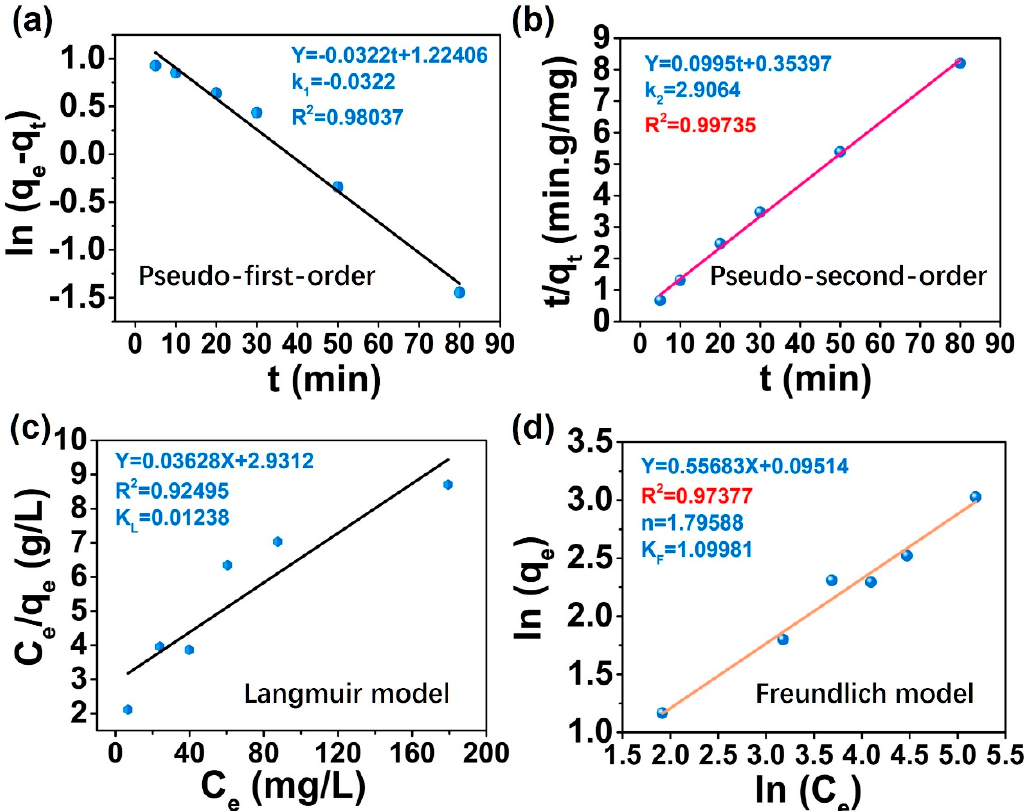
Figure 6. The kinetic fitting model of ( a ) Pseudo-first-order plot and ( b ) Pseudo-second-plot. ( c ) and ( d ) are the Langmuir and Freundlich isothermal models for adsorption of Cu(II) metal ions by the multi-structured SiO 2 @PVDF-HFP membrane. Table 1. Kinetic parameters for the pseudo-first-order and pseudo-second-order models of Cu(II)